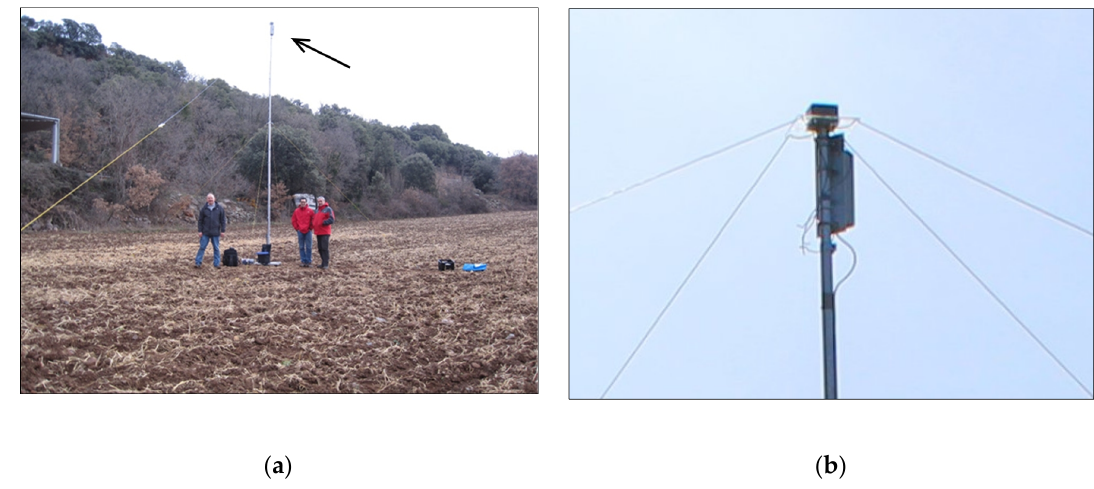
Figure 9. One of the six probe transmitters in Cal Cerdanyola. ( a ) The complete system including the wire antennas; ( b ) A close up of the compact (23 cm × 8 cm × 8 cm) probe transmitter on top of the mast.